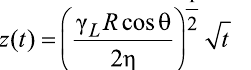
constant over a period of 5 minutes and was equal to 165 ±